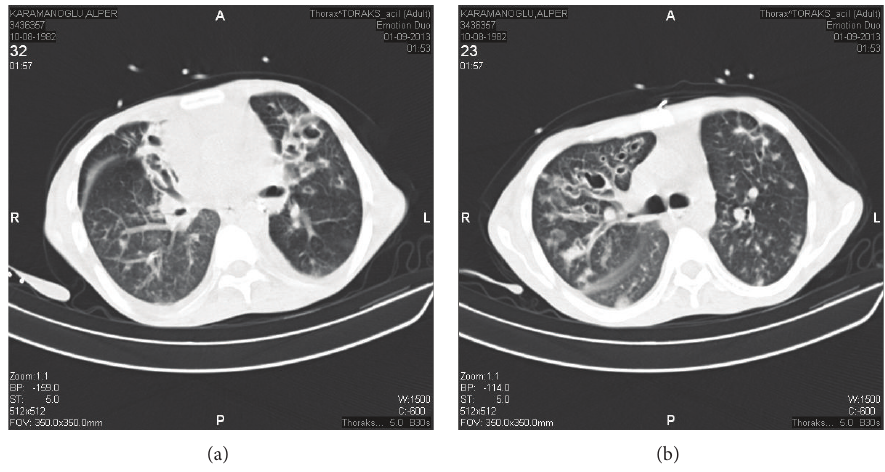
Figure 1: Thoracal CT of the patient shows bilateral bronchiectatic